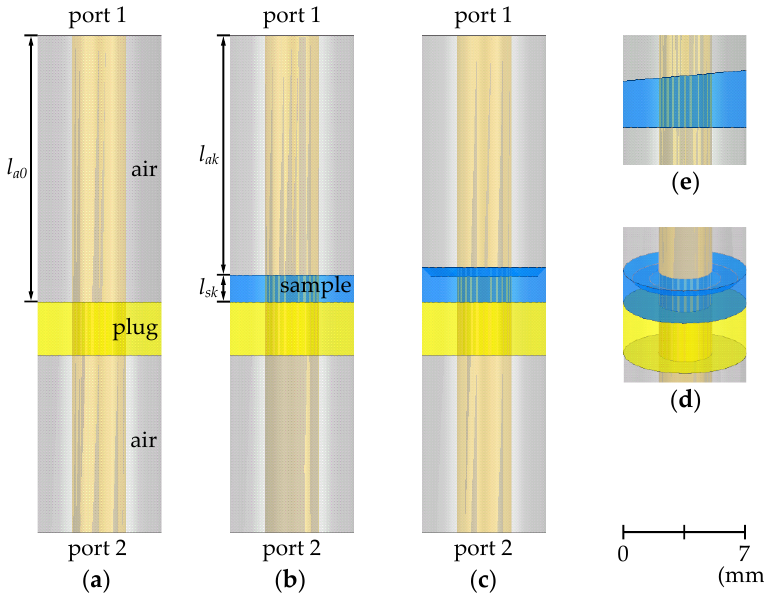
Figure 4. The simulated semi-open coaxial test fixture. Cases: ( a ) the empty cell, ( b ) the ideal sample of liquid with the flat upper surface, ( c ) the sample with the meniscus; ( d ) another view of the meniscus under analysis; ( e ) the tilted